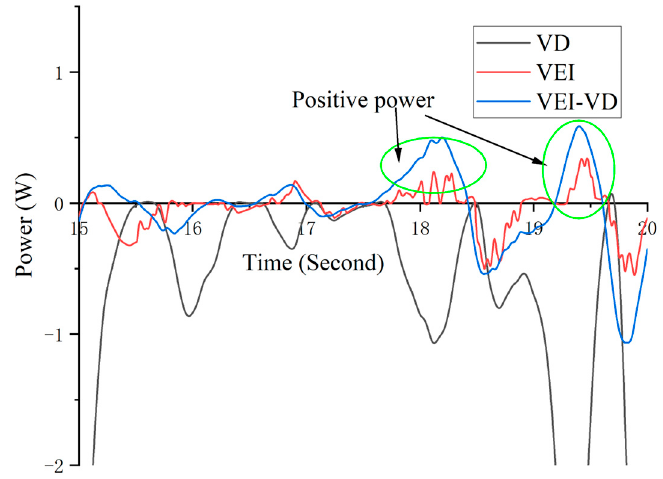
Figure 22. The power of semi-active seat suspension.